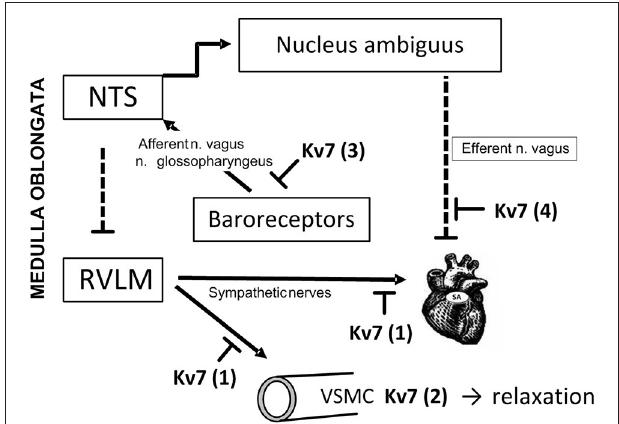
FIGURE 10 | Kv7 channel targets in BP-homeostasis. Peripheral Kv7 channels may influence BP-control through several mechanisms.